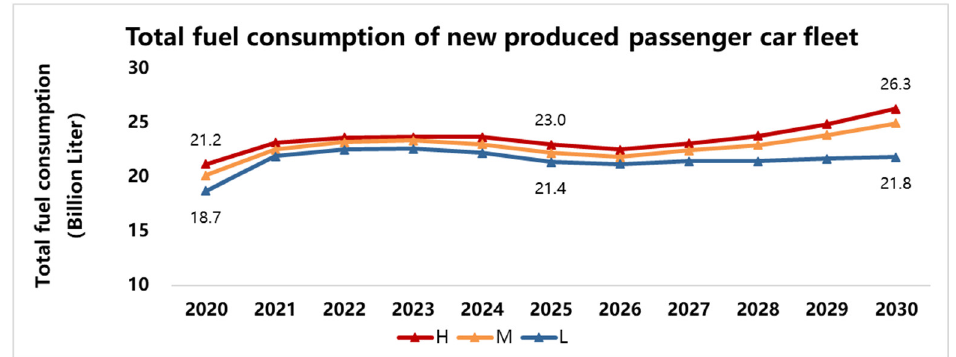
Figure 7. The total fuel consumption of newly produced passenger car fleet.